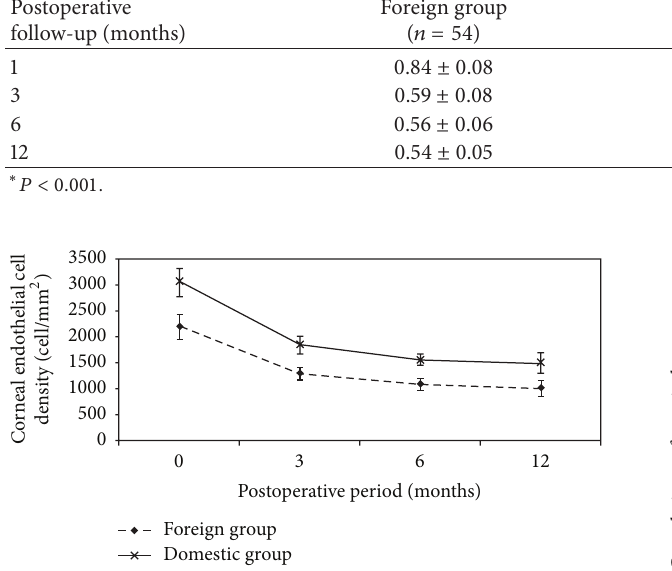
Figure 1: Corneal endothelial cell density (cell/mm 2 ) changes in foreign and domestic donor groups before surgery and at 3, 6, and 12 months postoperatively.